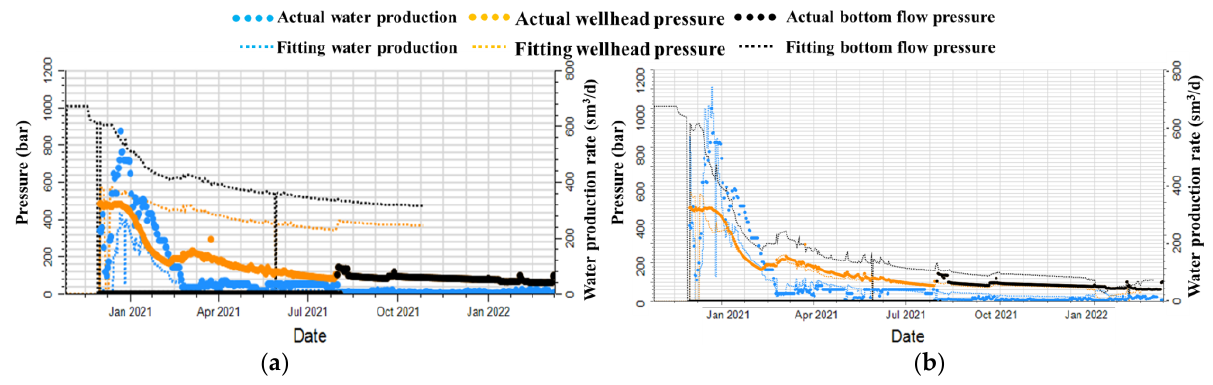
Figure 3. The results of historical production matching: ( a ) original; ( b ) reconstructed.